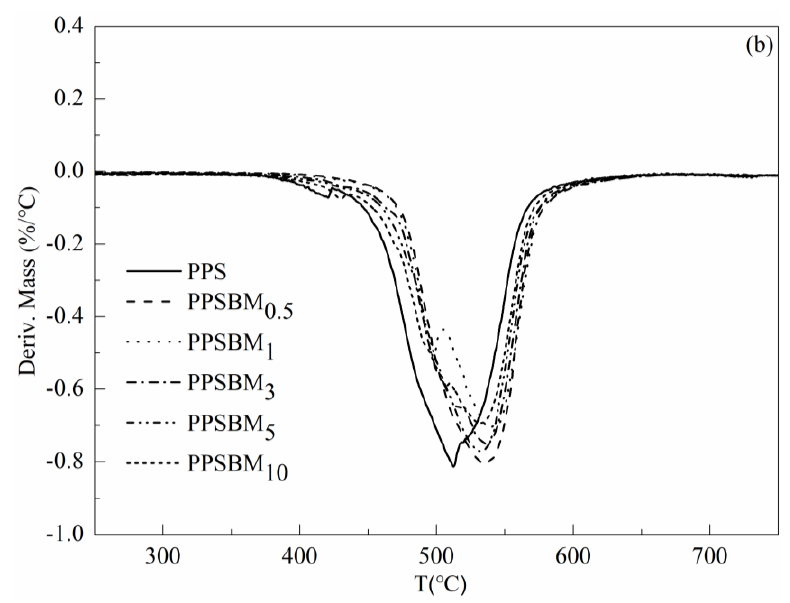
Figure 4. TGA ( a ) and DTG ( b ) curves of PPS and PPSBM x composites.